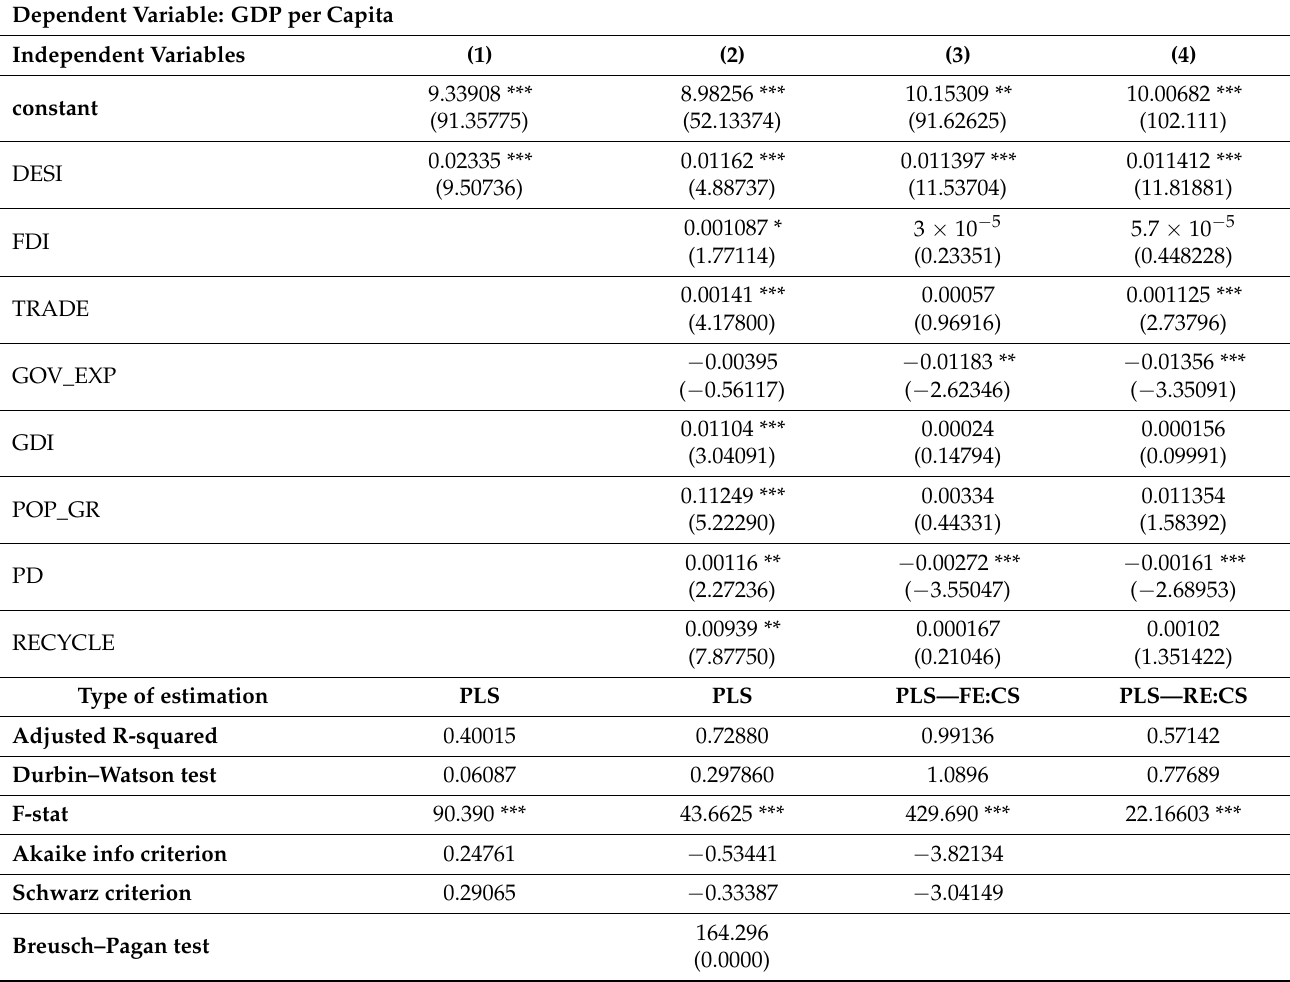
Table 9. Empirical results of panel regressions (DESI as independent